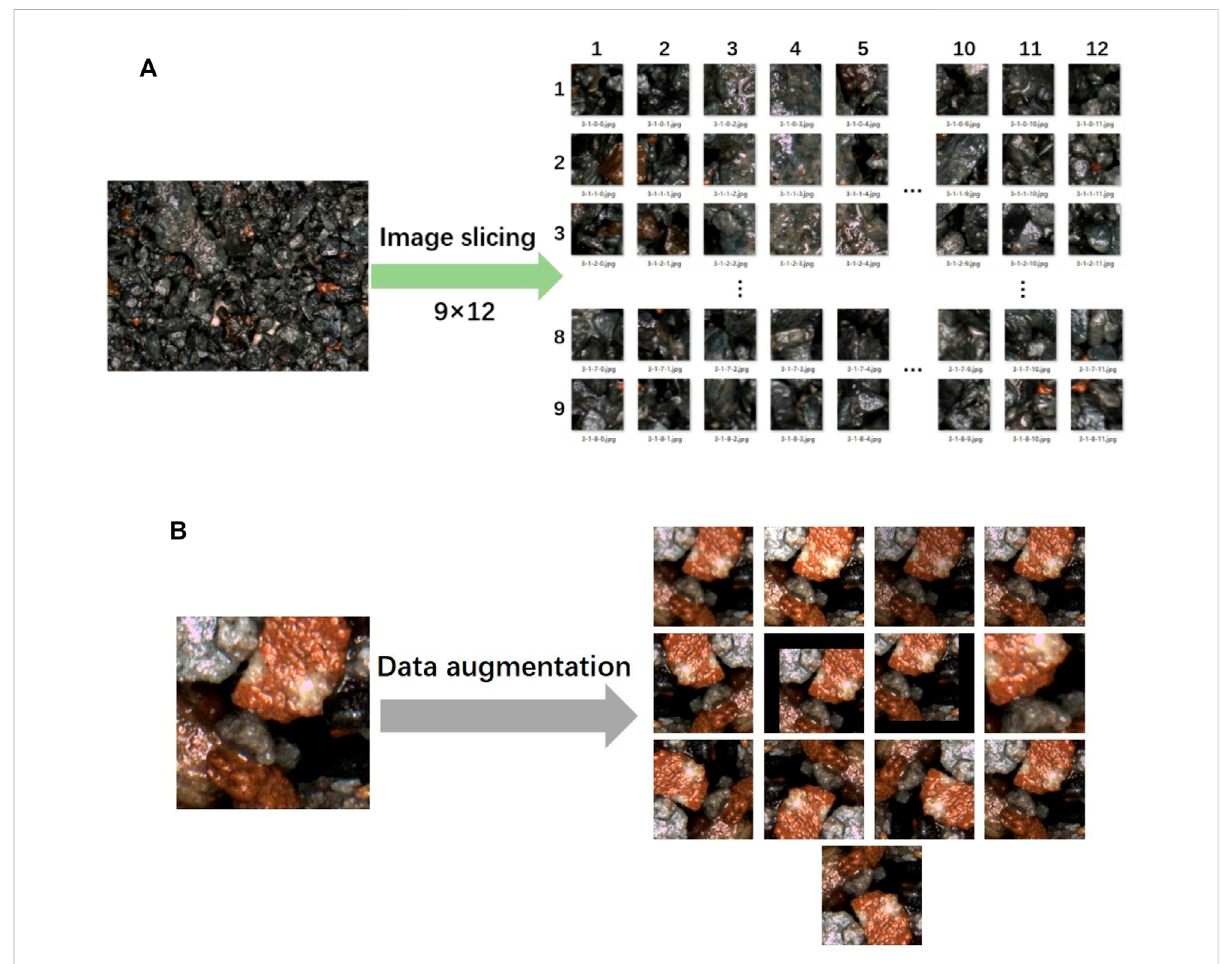
FIGURE 8 Data pre-processing of rock images: (A) Image slicing (B) Data